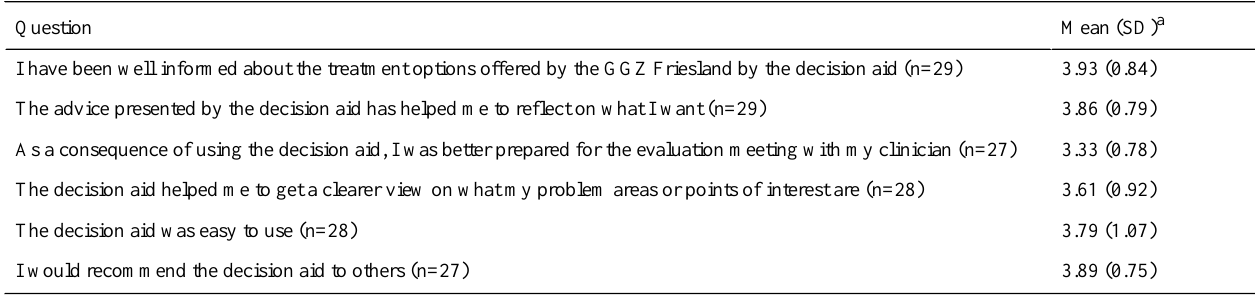
Table 4. Secondary outcome data of patients’satisfaction with the Web-based decision